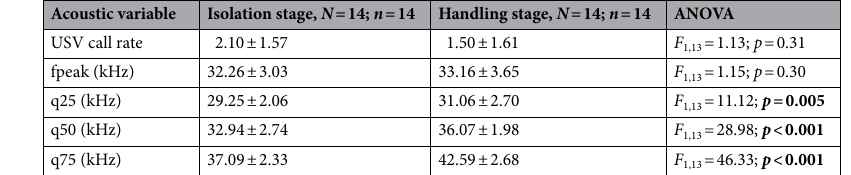
Table 2. Values (mean ± SD ) of USV call rate and of the acoustic variables of joint USVs and repeated measures ANOVA results for comparison between isolation and handling experimental stages. Designations: N —the number of individuals; n —the number of joint USVs; USV call rate—the number of USVs per second; fpeak—the frequency of maximum amplitude; q25, q50, q75—the lower, the medium and the upper quartiles. Significant values are marked in